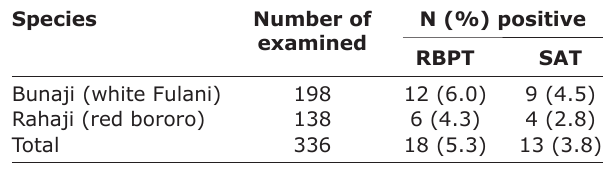
Table-4: Seroprevalence of bovine brucellosis in Bauchi State, Nigeria based on breeds distribution. Species